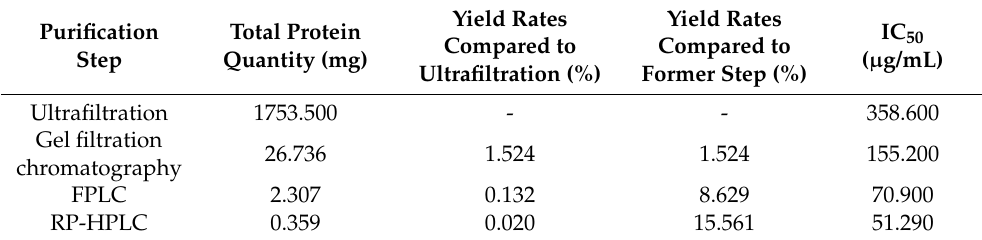
Table 2. Effectiveness of various separation operations denoted by protein yield and IC